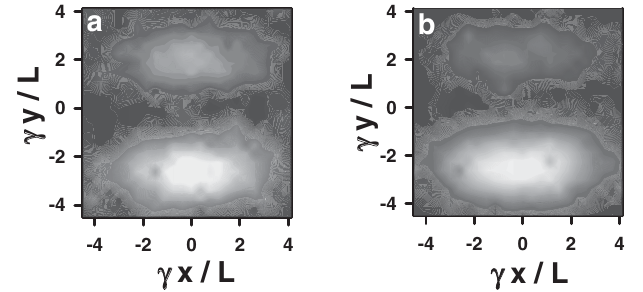
FIG. 21. Three-dimensional spatial distribution of ODR verti- cal polarization component measured without the lens and for two electron trajectory offsets with respect to the slit center: